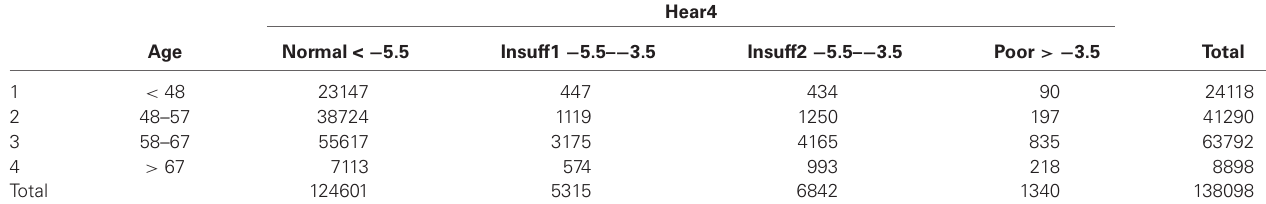
Table 5 | Number of persons in Age-groups and the four-step Hearing status groups.